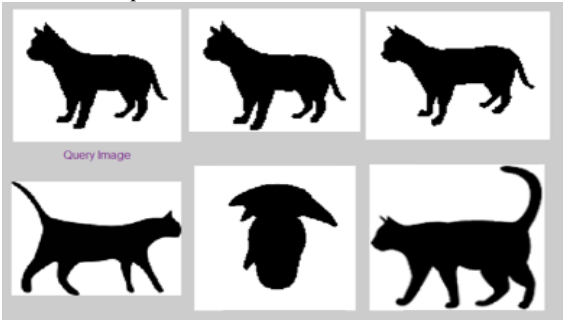
Figure 13. Final resultant fused image (Dataset